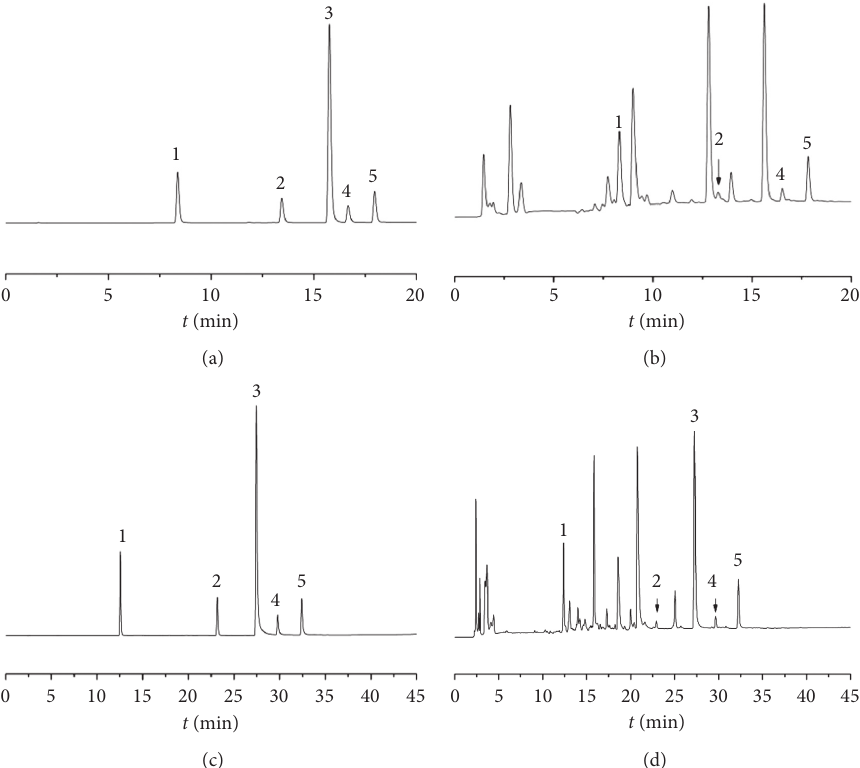
Figure 3: Chromatograms of the standard solutions and sample solutions. (1) Ethyl gallate. (2) Astragalin. (3) Quercetin. (4) Luteolin. (5) Kaempferol. (a) Mixed standard solution (UPLC); (b) sample solution (UPLC); (c) mixed standard solution (HPLC); (d) sample solution (HPLC). Table 1: Results of linear relationships for the 5 components.